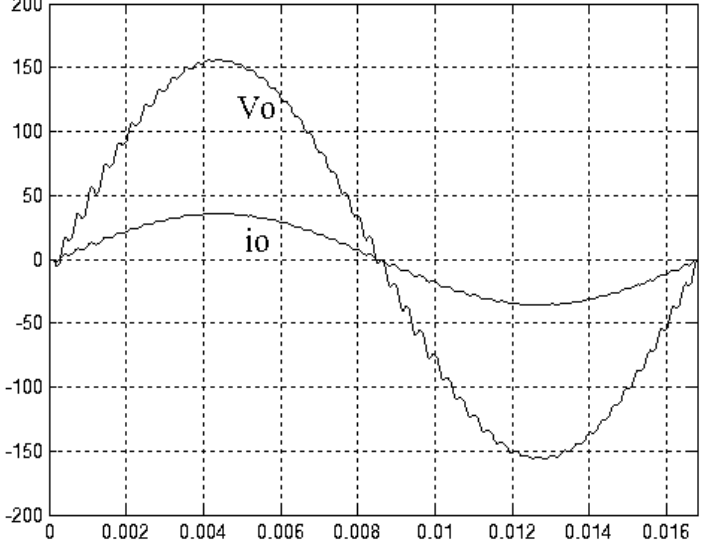
Figure 6. Simulation output waveforms against filter parameter variations obtained using the conventional SMC. Table 2. Simulation comparison of output voltage drop and